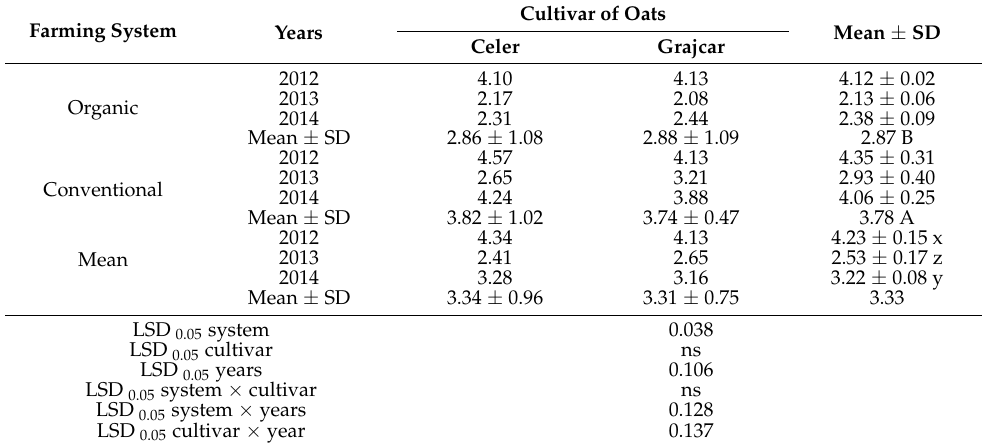
Table 4. Seed yield (t ha − 1 ) of oat-vetch mixtures depending on the farming system and oat cultivar in